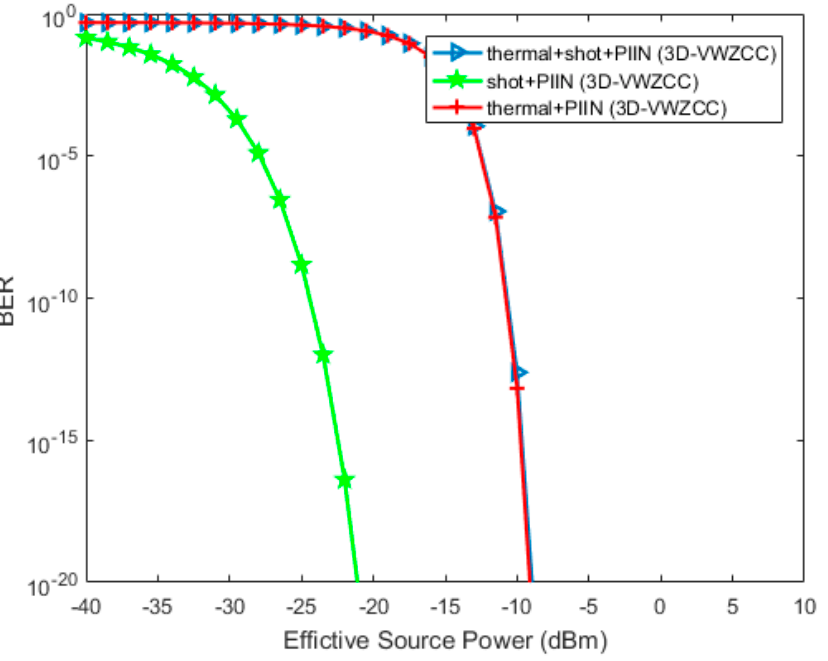
Figure 8. BER against effective source power when the number of simultaneous users K = 250 and data rate R b = 1.25 Gbps.